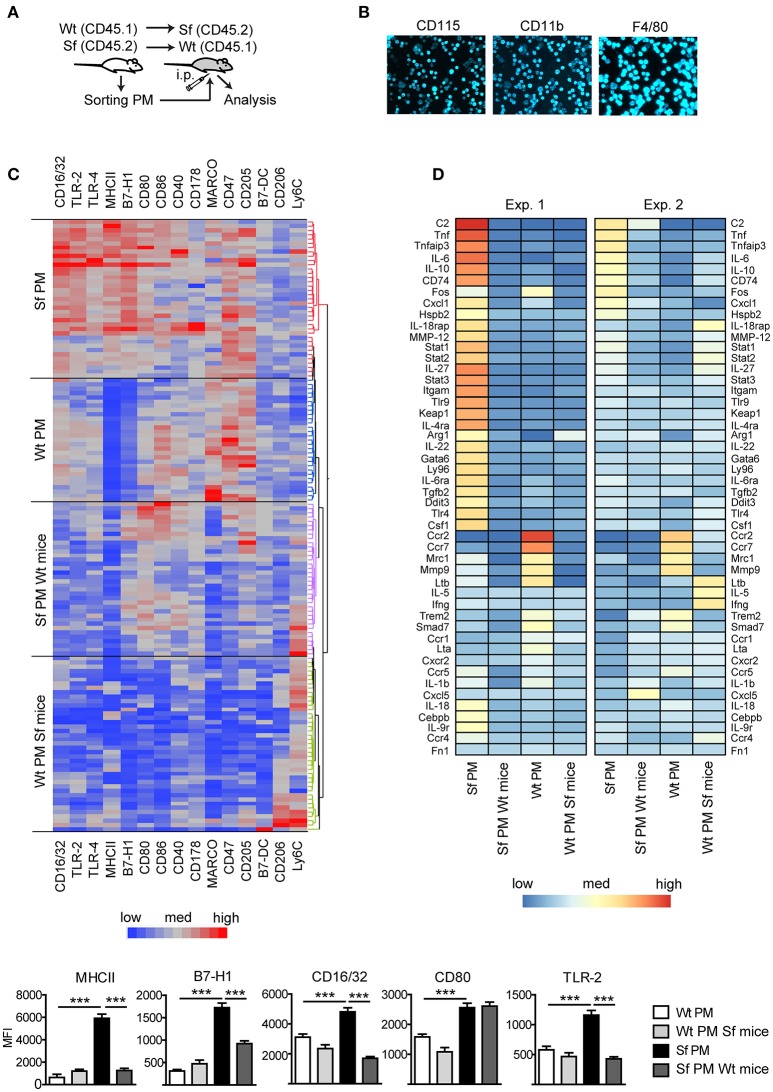
Immunophenotyping by single-cell chipcytometry and transcriptomics reveal plasticity of peritoneal macrophage activation profiles. (A) Schematic outline of the experimental protocol, (B) exemplary surface marker stainings of the cells fixed on chip, and (C) immunophenotyping of scurfy (Sf) and unaffected (Wt) peritoneal macrophages (PM) from the untreated mice and after their transfer to Wt or Sf peritoneal cavity (“Sf PM Wt mice” and “Wt PM Sf mice”), respectively, performed by single-cell chipcytometry. Data are depicted as mean fluorescent intensities (MFI) for each surface marker expressed by single cells and shown as heatmaps (middle) and bar graphs (bottom; n~60 cells per group, pooled from more than 8 donor mice). (D) Microarray-based transcriptome analysis of gene expression in PM from untreated Sf and Wt mice and after their intraperitoneal (i.p.) transfer to Wt or Sf mice, respectively (“Sf PM Wt mice” and “Wt PM Sf mice”; two independent experiments, each experimental group contains pooled cells from more than 5 mice). Statistical analysis was performed using one-way ANOVA, ***p < 0.001.